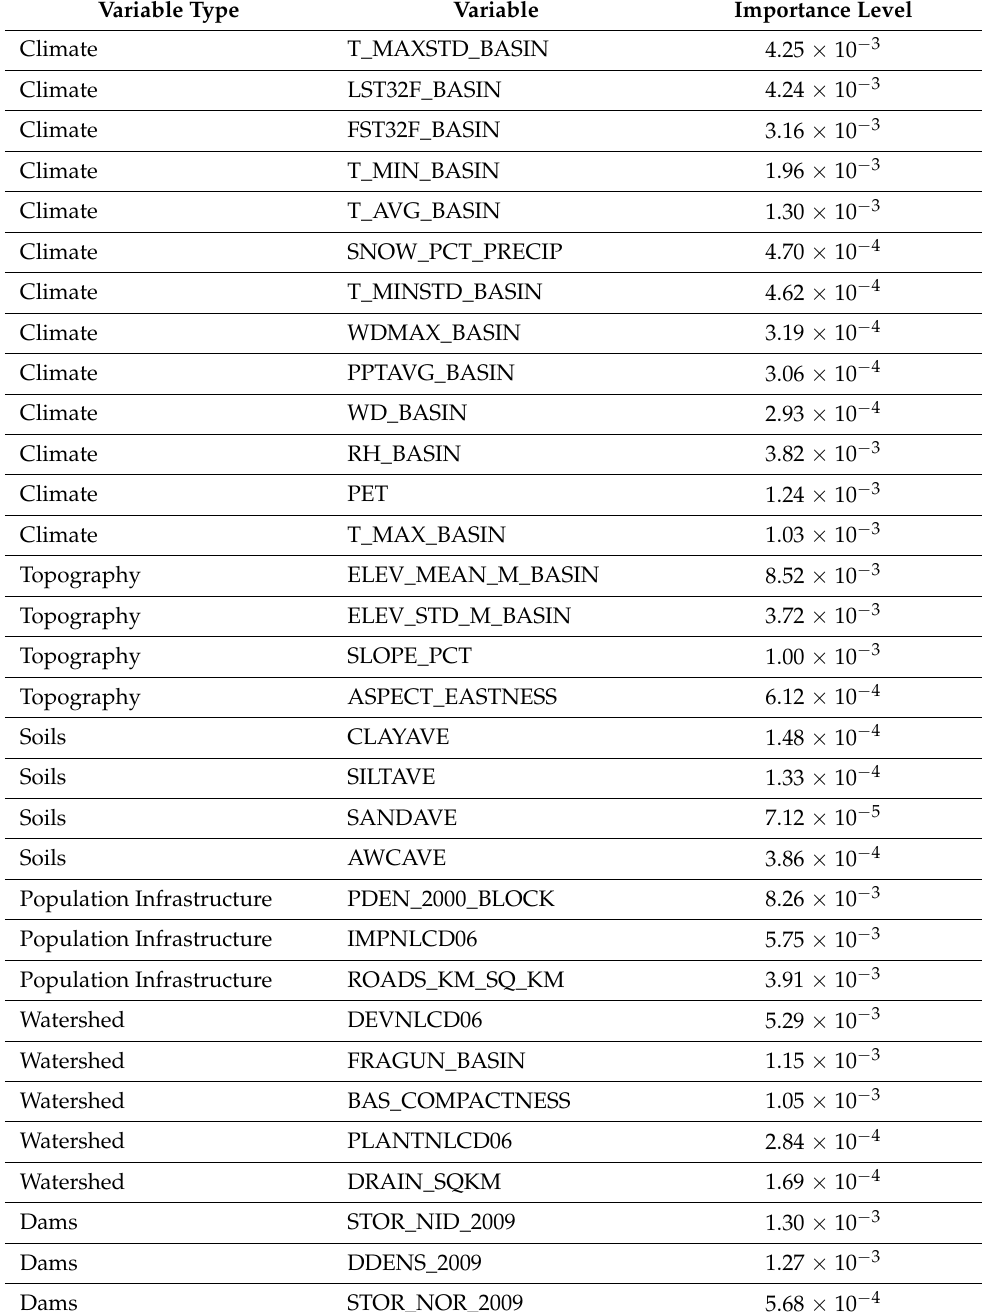
Table A2. Predictor variables retrieved for Central